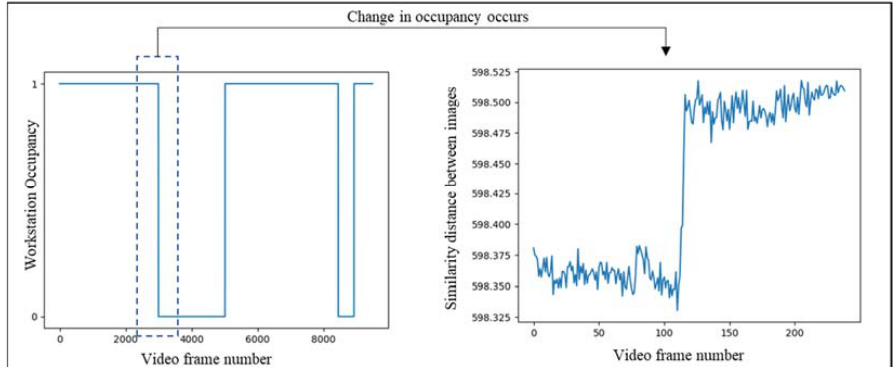
Figure 17. Change in the cost of matching indicating a change in the state of the station.